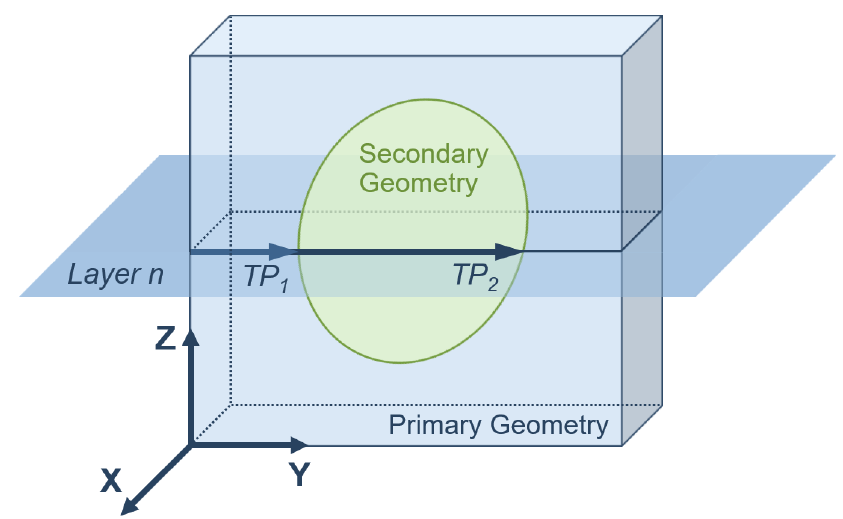
Figure 3. Concept of generating trigger points using a secondary geometry.